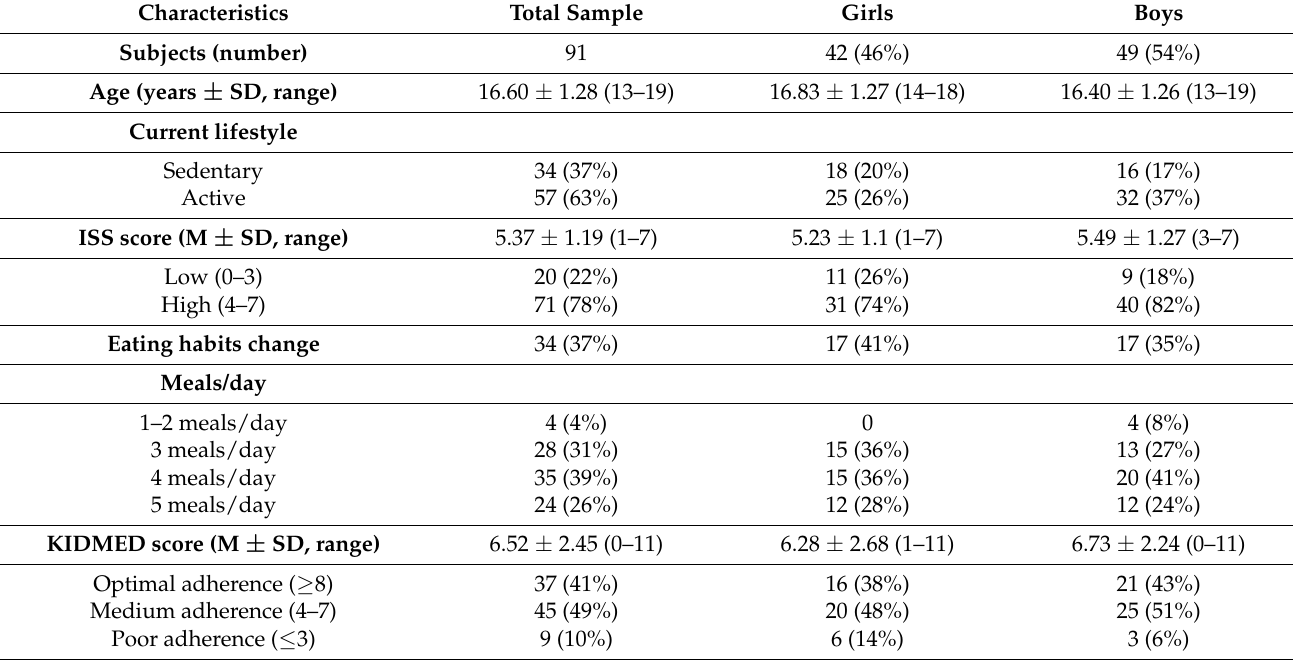
Table 1. General characteristics of our study population.